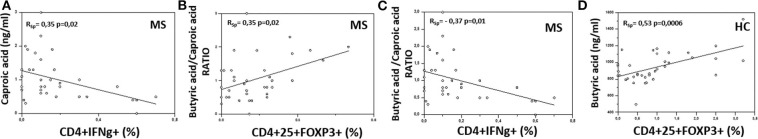
Correlation between the serum concentration of butyric and caproic acid and their ratio and peripheral immune cells in MS and healthy controls. Rank correlation between: (A) serum caproic acid concentration and peripheral IFNγ-producing CD4+ T cell percentage, (B) butyric acid/caproic acid ratio and Treg (CD4+/CD25high/Foxp3+) cell percentage, (C) butyric acid/caproic acid ratio and TH1 (CD4+/IFNγ+) cell percentage in Multiple Sclerosis patients (MS) (n = 38); (D) serum butyric acid concentration and Treg (CD4+/CD25high/Foxp3+) cell percentage in healthy controls (HC) (n = 38). Statistical correlations were investigated by the Spearman correlation coefficient and 95% confidence limits performed by Fisher's Z transformation. Statistical significance and Spearman's coefficient of rank correlation (RSp) are shown.